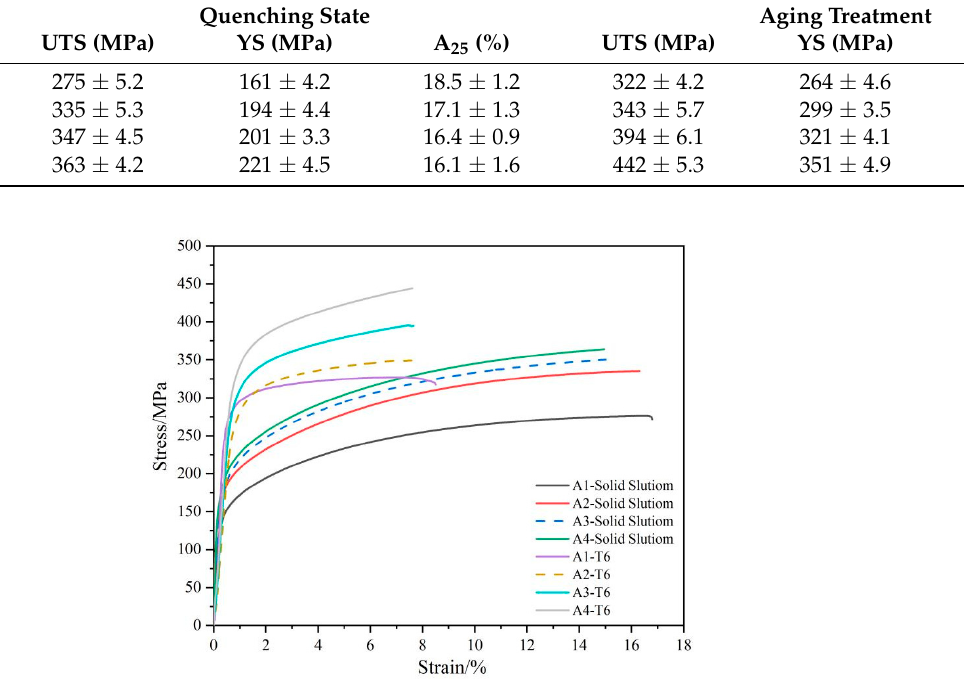
Figure 12. Engineering stress–strain curves of the alloys after solid solution and aging treatment.